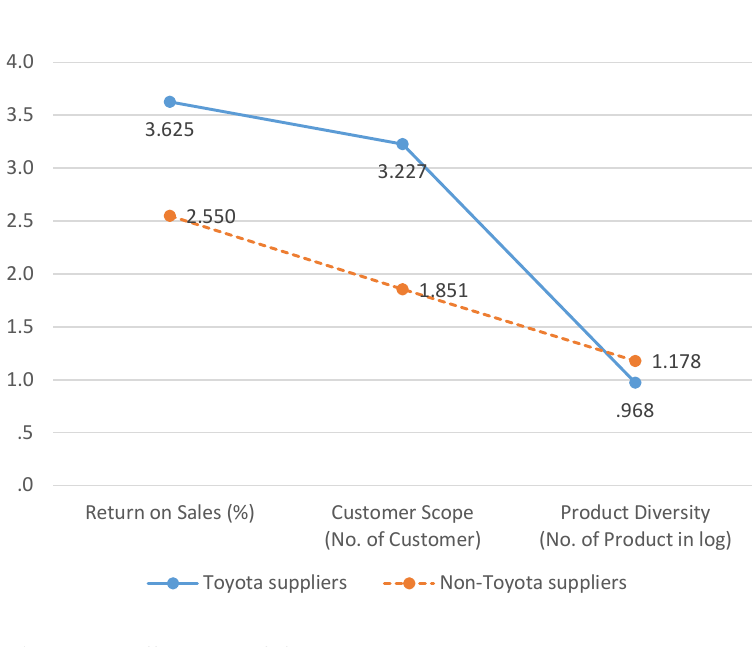
Figure 1. Differences of the mean (Toyota vs.